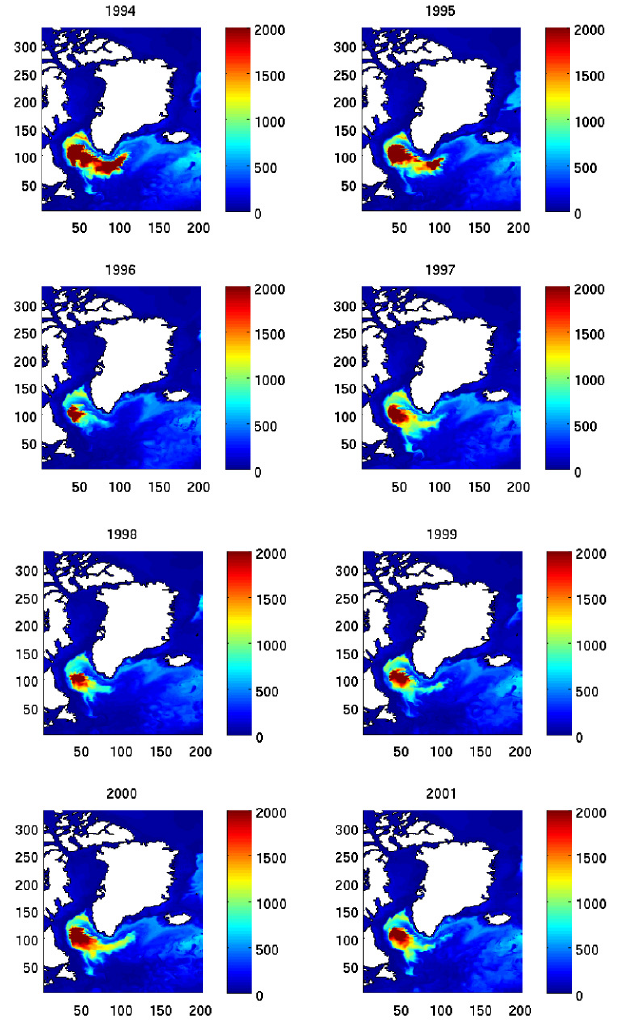
Fig. 12. March mixed layer depth (m) for the period 1994–2001 in the control experiment.